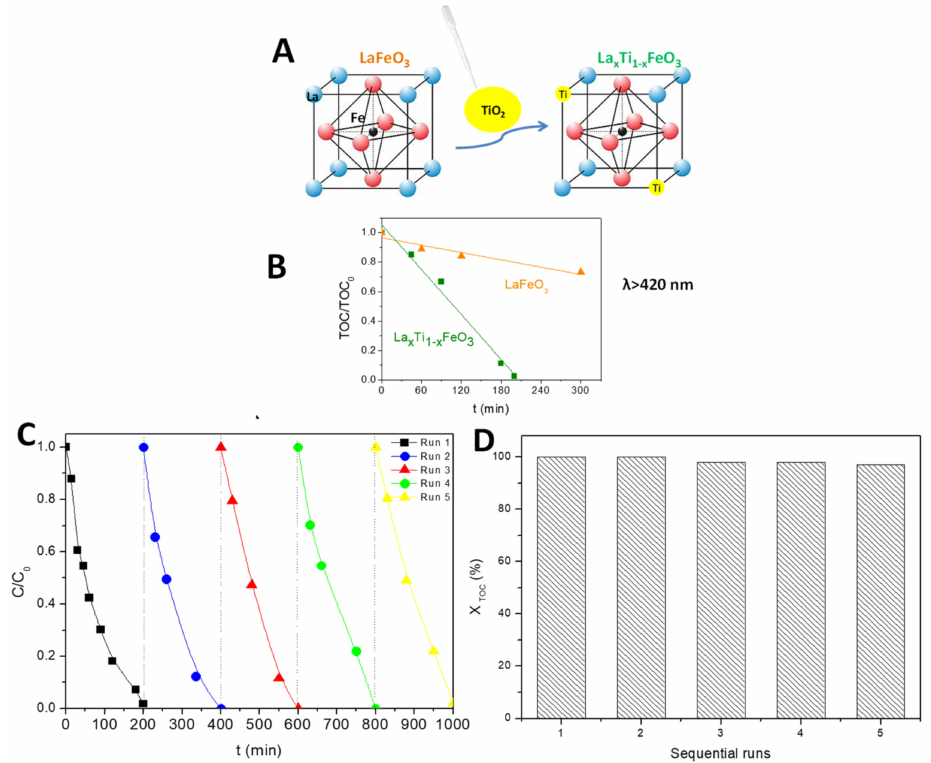
Figure 5. ( A ) Partial substitution of TI by La LaFeO 3 crystal structure and ( B ) the resulting TOC removal rate improvement under pure visible light ( λ > 420 nm). Reproduced with permission from Ref. [108]. Copyright Elsevier. Reusability tests performed on the La 1 − X Ti X FeO 3 dual catalyst in the system H 2 O 2 /visible light: ( C ) Evolution of the relative 4-Chlorophenol concentration and ( D ) TOC mineralization degree obtained after 210 min of test. Operating conditions: [4-Cl-Phenol] 0 = 25 mg/L; [H 2 O 2 ] 0 = 125 mg/L; T = 25 ◦ C; [cat] = 0.5 g/L; ( λ > 420 nm). Reproduced with permission from Ref. [108]. Copyright